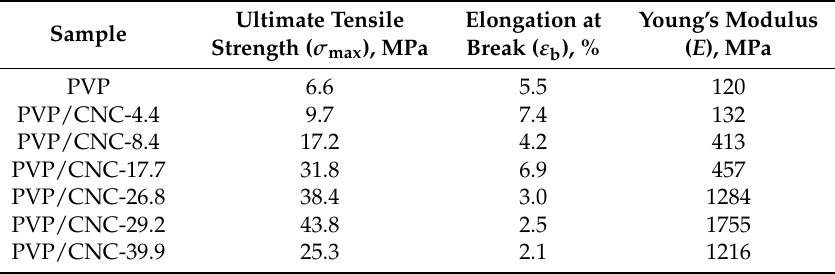
Table 3. Tensile properties of the PVP/CNC composite